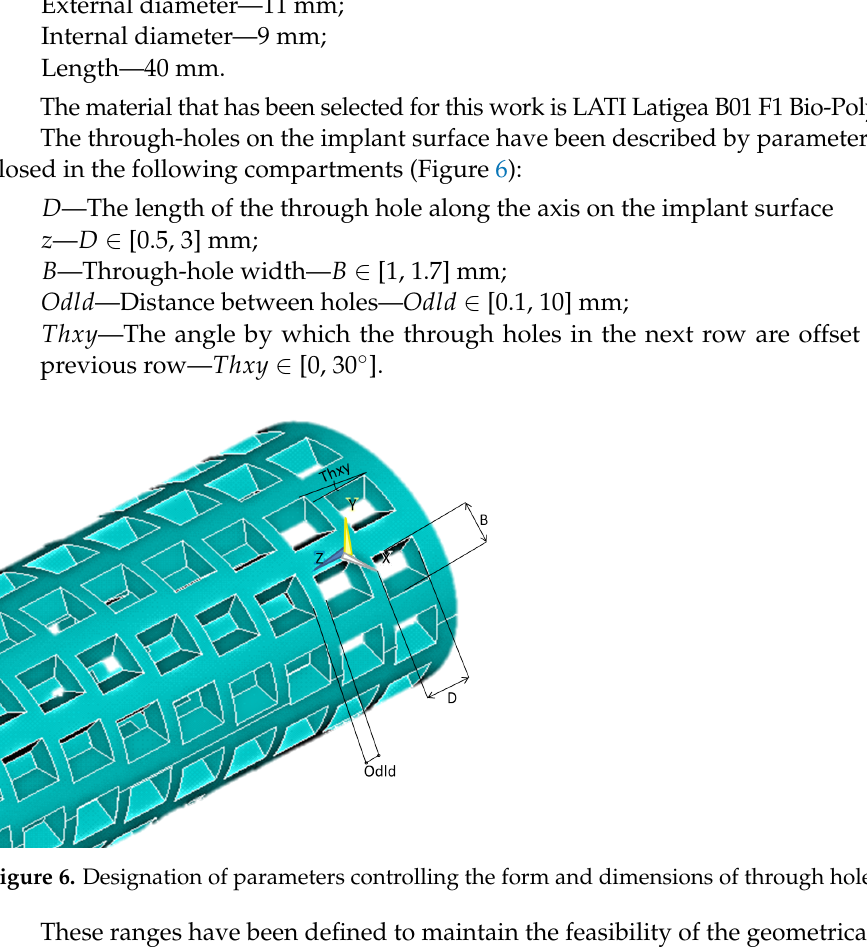
Figure 7. An exemplary individual is saved with four